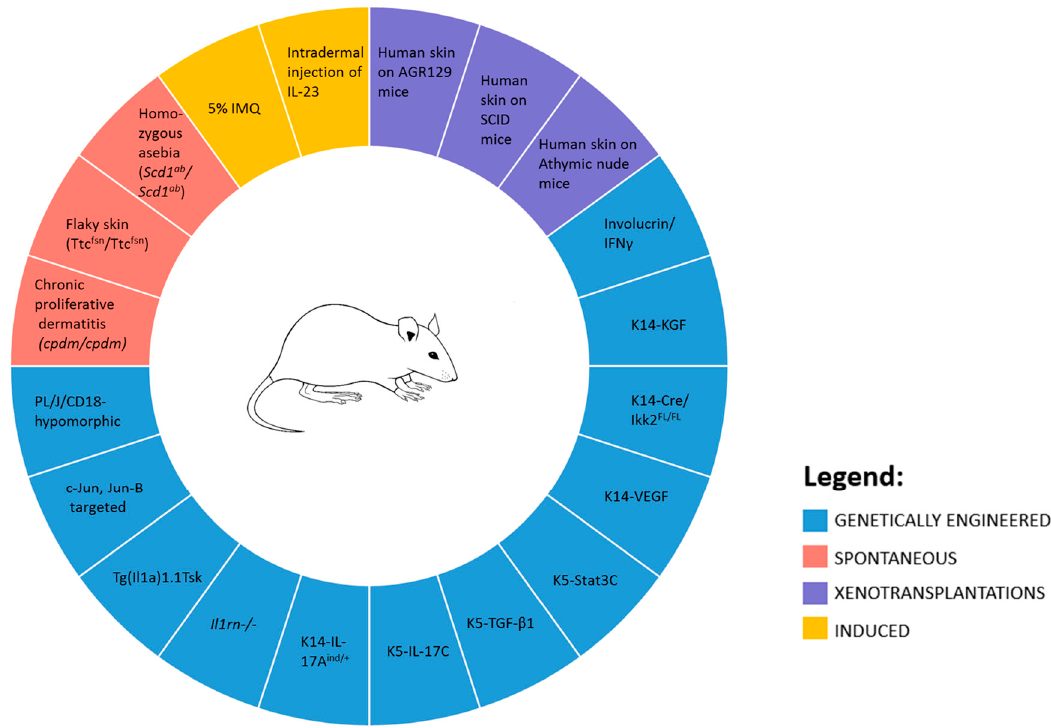
Figure 3. Murine models of Ps.